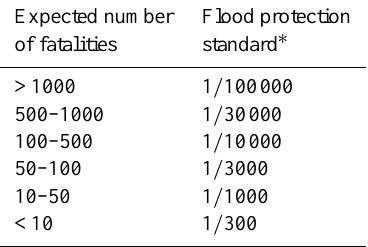
Table 2. The relationship used between the expected number of fa- talities given a breach (taking into account evacuation possibilities) and the required safety standard as used in alternative